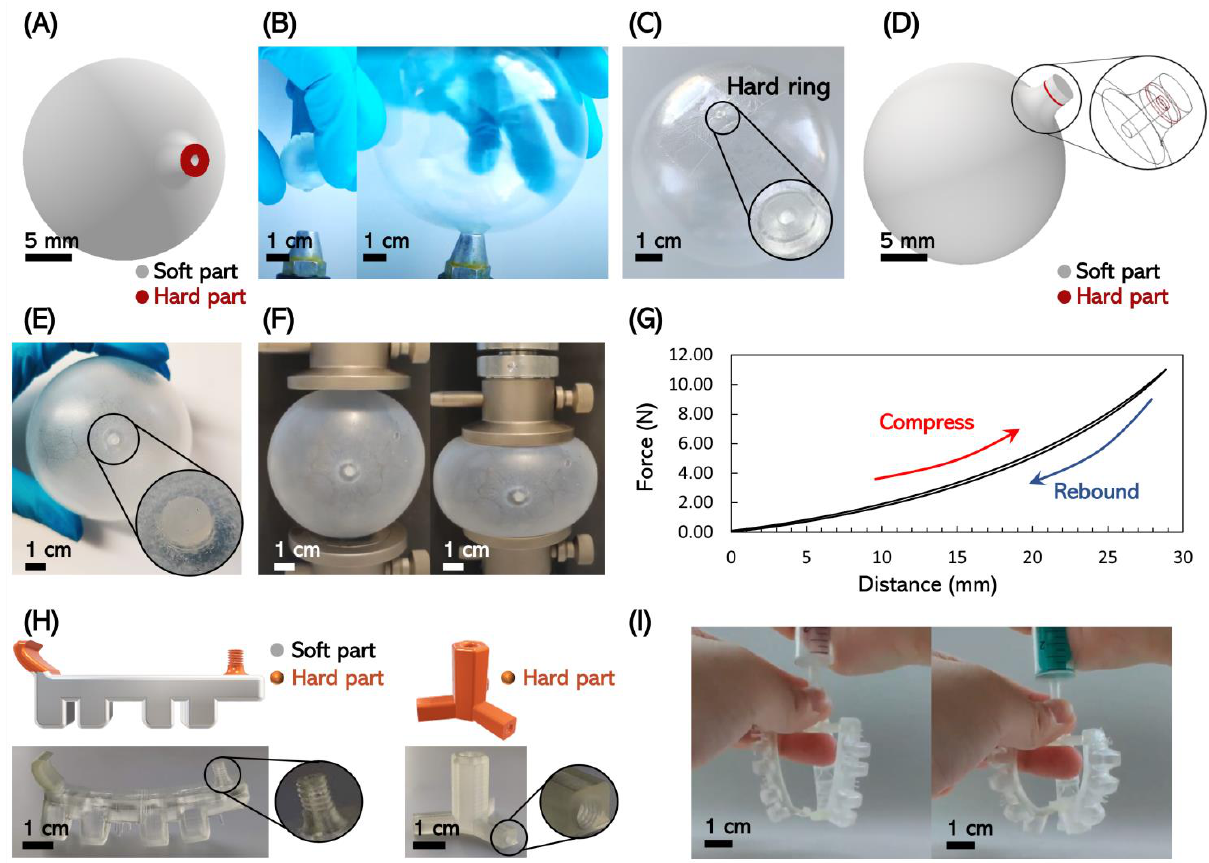
Figure 3. Three-dimensional printing of multi-material actuators. ( A ) Design of a multi-material balloon (diameter = 20 mm; thickness = 2 mm; diameter of the inlet: outside = 3 mm, inside = 1 mm; thickness of the hard disk (red part) = 0.5 mm). ( B ) Printed balloon in the non-inflated and inflated states. ( C ) Inflated balloon with a hard ring to fix the inlet, which was sealed using tape, as the hard ring was not deformed. ( D ) The design of a multi-material balloon with a soft valve as a lumen subjected to compression testing. ( E ) Balloon with a soft valve that had already been inflated with a needle, and no obvious pinhole existed in the soft valve. ( F ) Compression tests of an inflated balloon with this valve demonstrated that no air leaked from the balloon. ( G ) The curve of the compression test of the ( F ) process, where the agreement of the compression and rebound curves illustrated the airtightness. ( H ) Multi-material actuator with a hard, 3D printed threaded inlet for a pressure supply connector directly manufactured into a soft gripper and the hub structure with threaded sleeves, which could be assembled with actuators. ( I ) The assembled pneumatic gripper in non-actuated (left) and actuated states